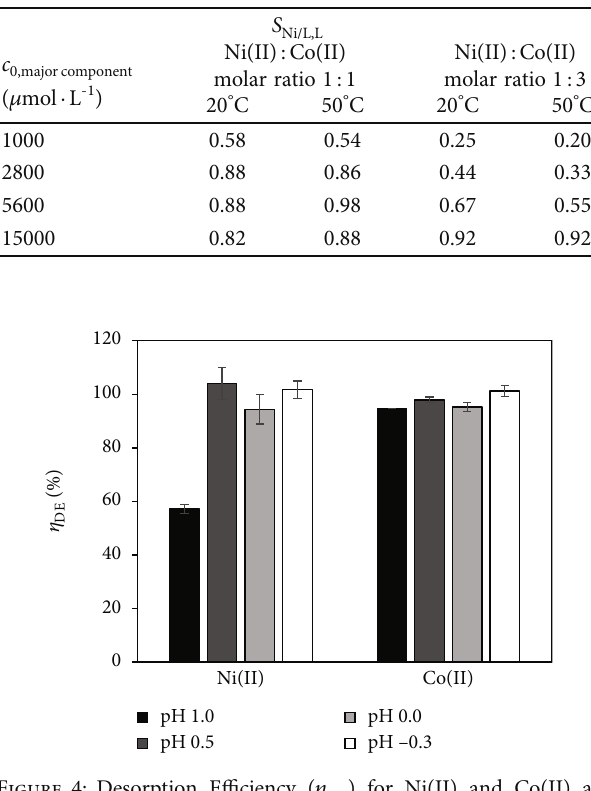
Table 6: Selectivity of reaction engineering ( S adsorption onto HSU331 in dependence of molar ratio, initial concentration, and temperature.